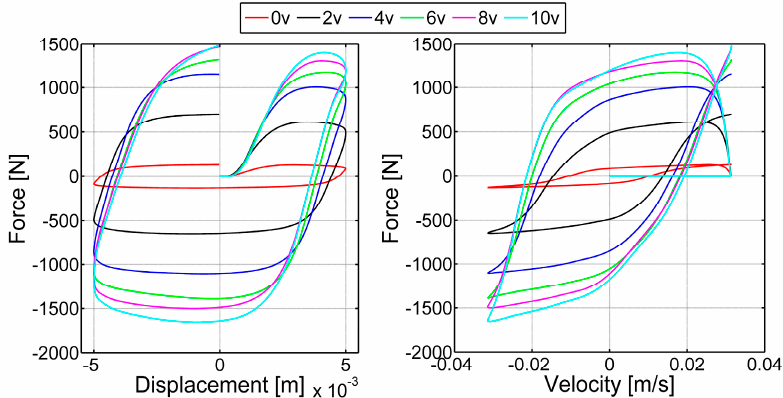
Figure 5. Characteristics of the magnetorheological (MR) damper.